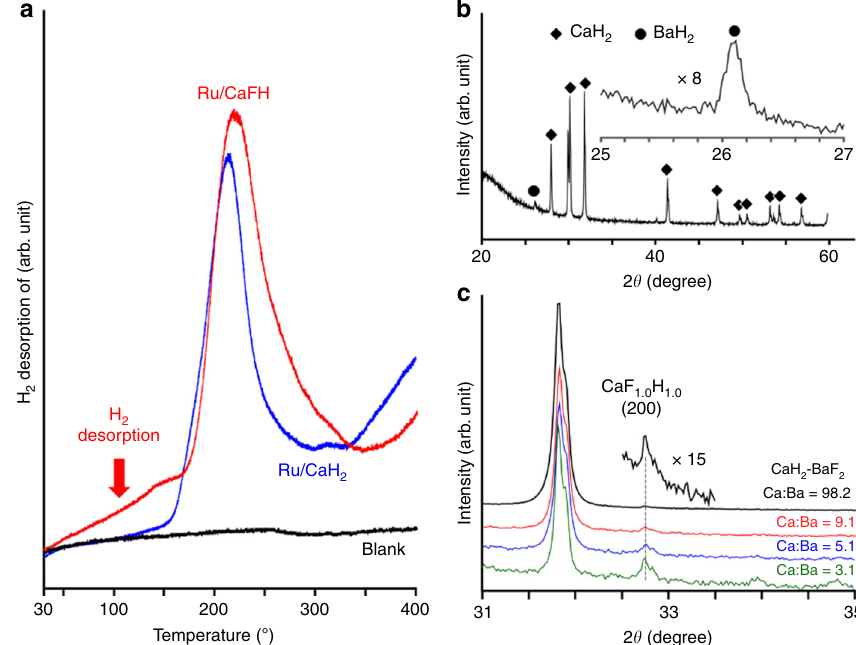
Fig. 2 H 2 -TPD and XRD for prepared materials. a H 2 -TPD pro fi les for Ru/CaH 2 and Ru/CaFH after ammonia synthesis reaction at 340 °C, followed by cooling down below 20 °C. TPD measurements were performed under Ar fl ow (1 °C min − 1 ). b XRD pattern for CaH 2 – BaF 2 mixture (Ca:Ba = 98:2) after heating at 340 °C for 10 h in H 2 . c Narrow-range XRD patterns for CaH 2 – BaF 2 mixtures (Ca:Ba = 98:2, 9:1, 5:1, and 3:1) after heating at 340 °C for 10 h in H 2